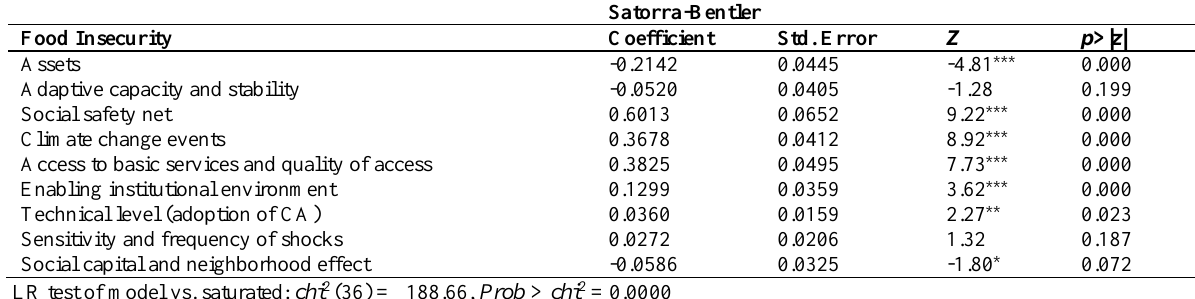
Table 4: SEM Estimates: Correlates of Farmers’ Resilience to Food